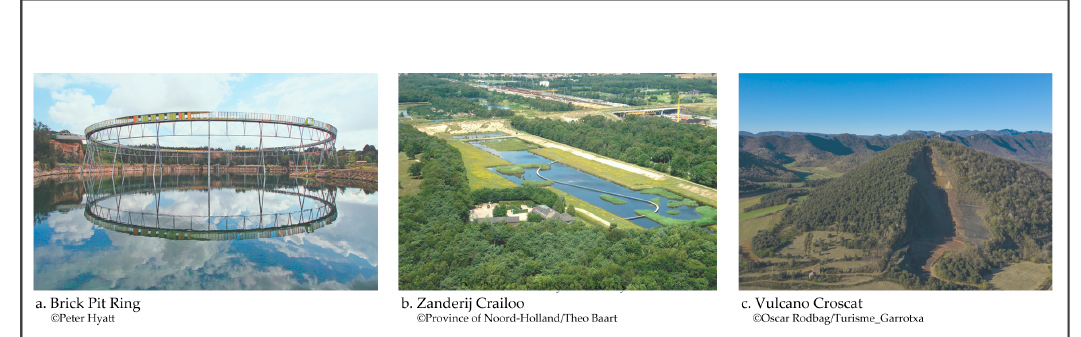
Figure 10. Selected projects related to biodiversity and geodiversity aspects.